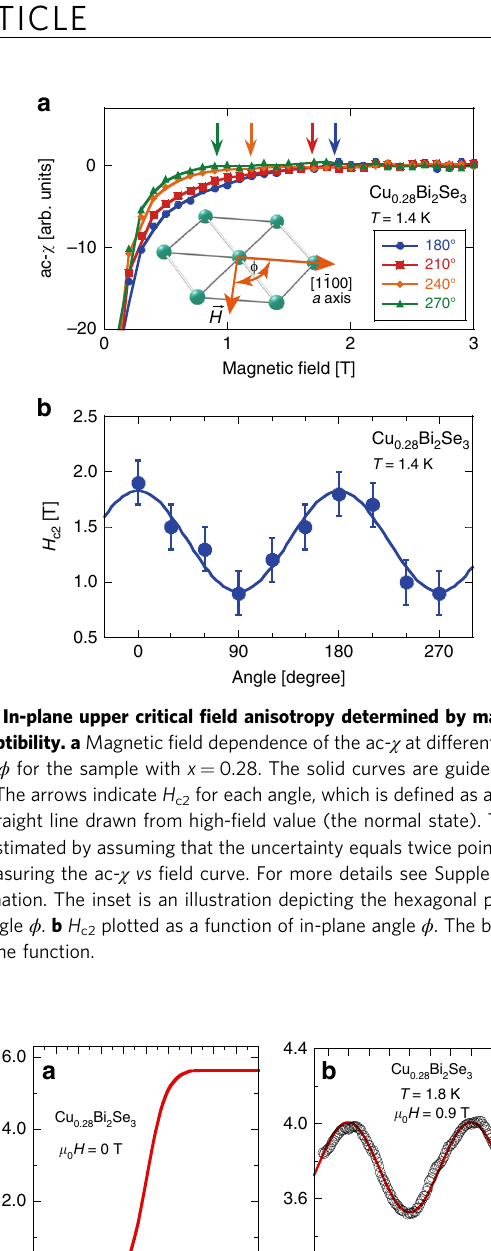
Fig. 5 Magneto-resistance measurements. a Temperature dependence of the electrical resistance at zero magnetic fi eld, which is in agreement with ref. 34 . b Electrical resistance under a magnetic fi eld of 0.9 T and at T = 1.8 K as a function of in-plane angle ϕ . Note that a minimum in the electrical resistance corresponds to a maximal H c2 . The red curve is a sine function.